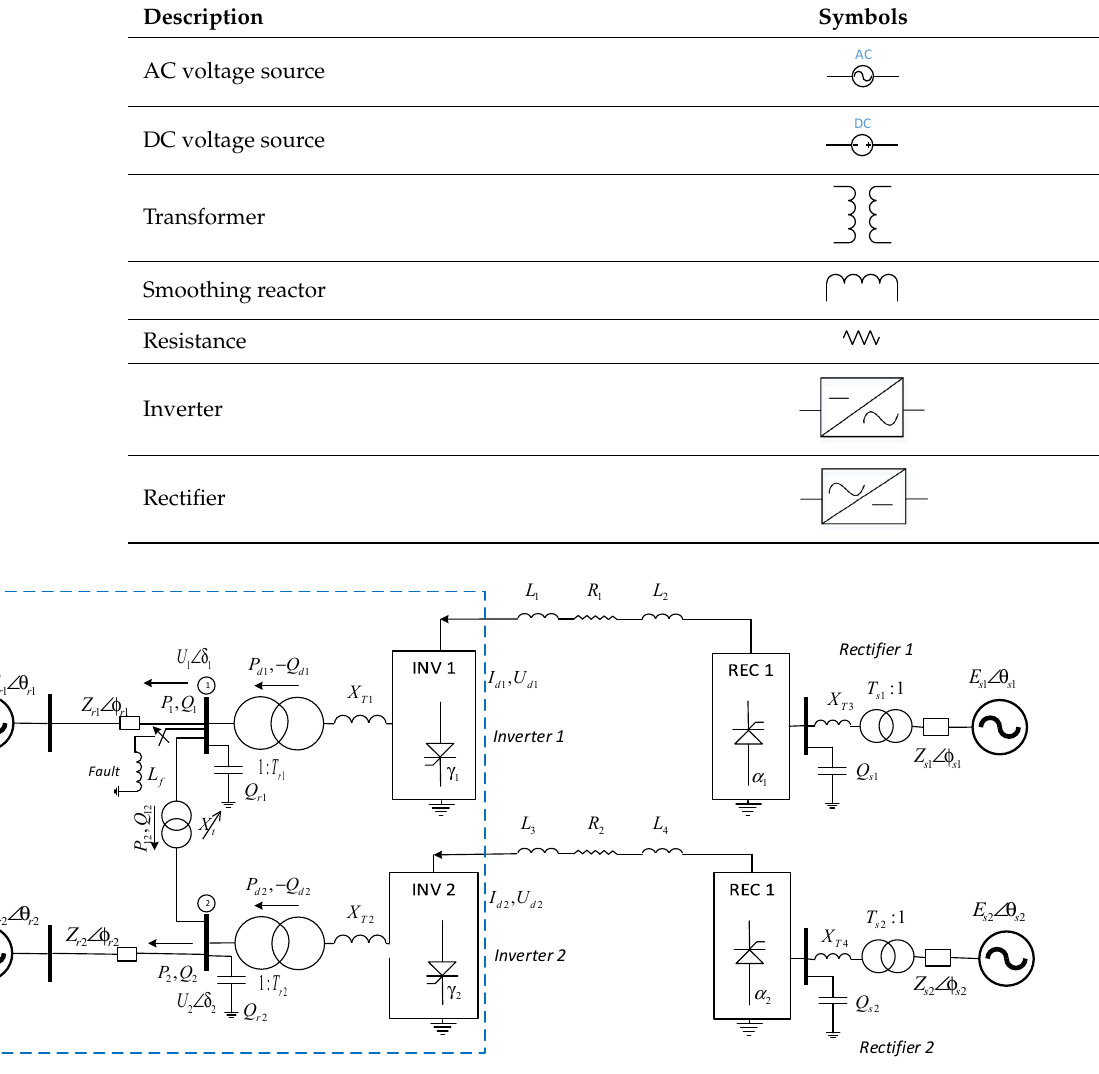
Table 3. Legends of symbols.